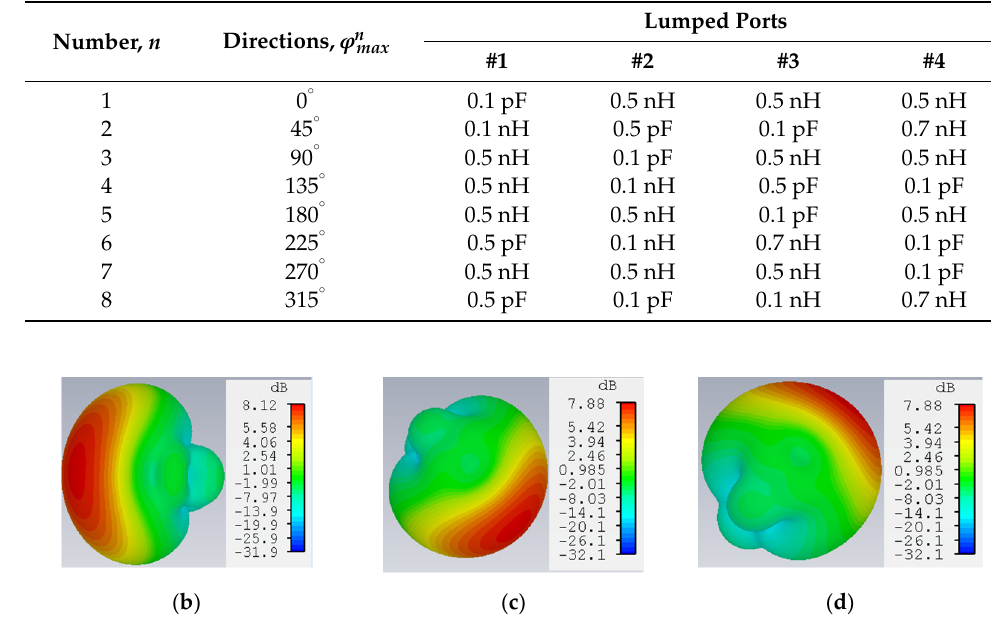
Figure 4. 3D radiation patterns of the antenna at: ( a ) 0 ◦ ; ( b ) 90 ◦ ; ( c ) 225 ◦ ; ( d ) 315 ◦ .